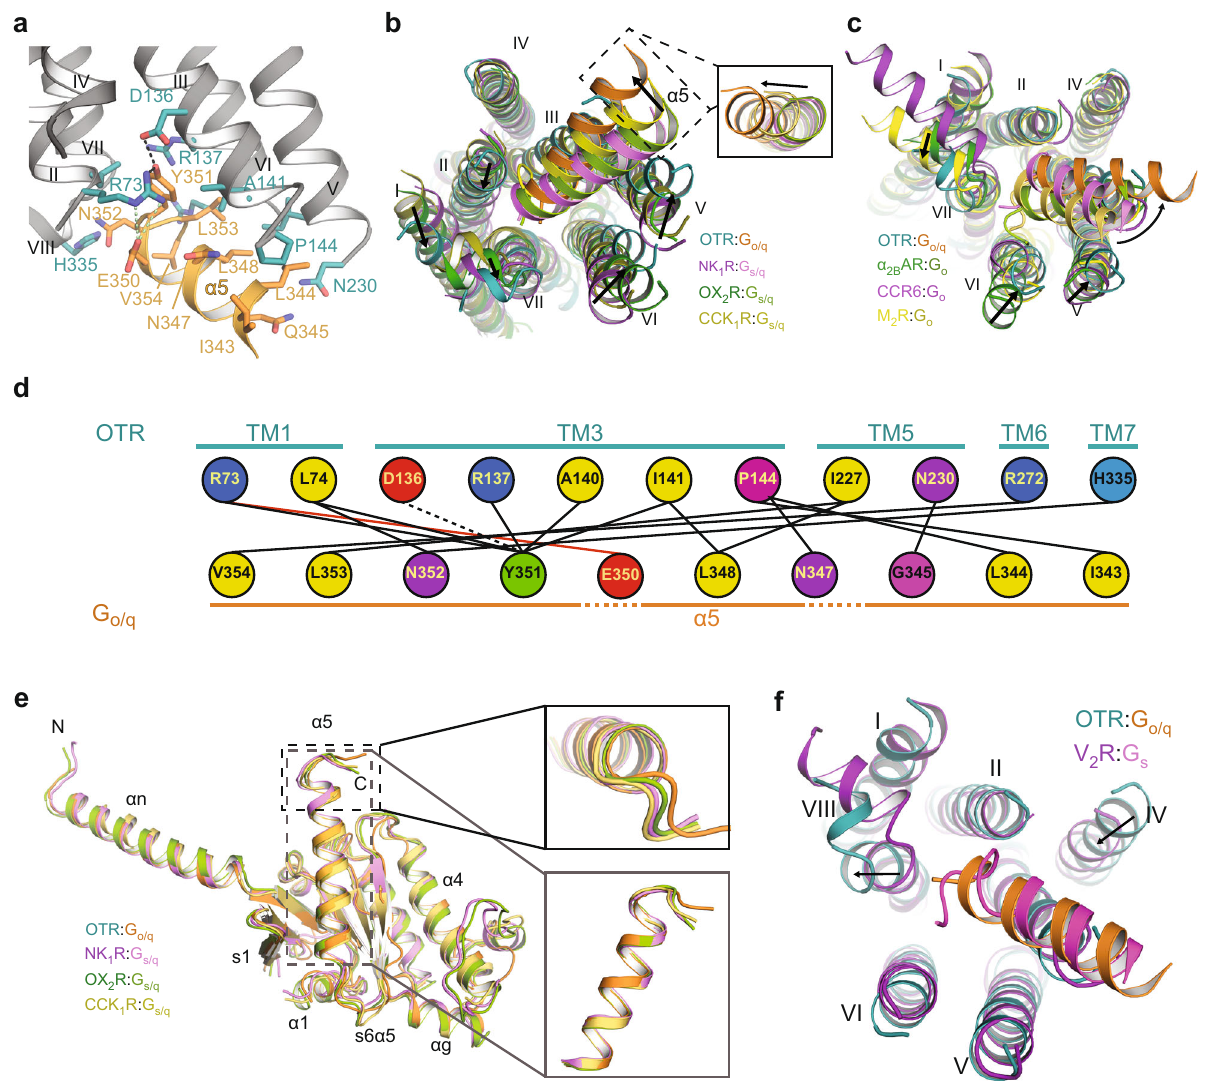
Fig. 5 Interactions of OTR and G α o/q . a Detailed interactions of G q α 5 with OTR. b Structural comparison of OTR:G o/q to G s/q complexes with focus on G q α 5 positioning: NK 1 R:G s/q (purple, PDB 7P00), OX 2 R:G s/q (green, PDB 7L1U), and CCK 1 R:G s/q (yellow, PDB 7MBY). c Structural superposition of OTR with α 1 AR:G o (green; PDB ID: 6K41), CCR6:G o (purple; PDB ID: 6WWZ), and M 2 R:G o (yellow; PDB ID: 6OIK) as viewed from the intracellular side with a focus on receptor – G protein interaction. Arrows indicate structural differences between intracellular receptor helix tips and α 5 orientations. d Schematic drawing of direct interactions between OTR and the α 5 helix of G α o/q . Hydrogen bonds are drawn as dashed lines. Salt bridges are indicated by lines coloured in red. Amino acids are coloured according to their biophysical properties. e Structural superposition of OTR-bound G o/q with G s/q from different signalling complexes: NK 1 R:G s/q (purple; PDB ID: 7P00), OX 2 R:G s/q (green; PDB ID: 7L1U), and CCK 1 R:G s/q (yellow, PDB ID: 7MBY) with two different close-up views on G α 5. f Structural comparison of OTR:G o/q and V 2 R:G s (pink, PDB 7KH0) with focus on helix α 5